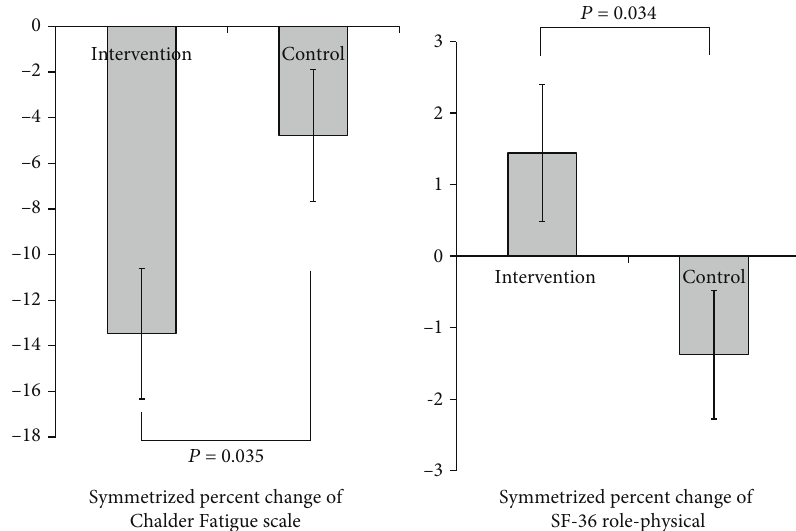
Figure 2: Mean comparison of the physical and mental fatigue score changes and role-physical score changes (Symmetrical Percent Change). Table 2: Group comparison of the symmetrical percent change of